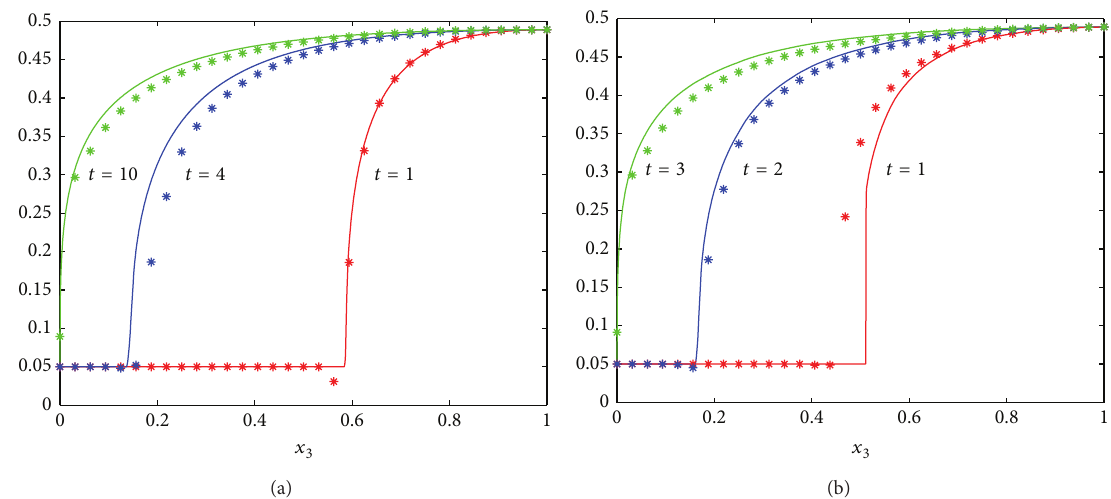
Figure 2: The HMM-FEM solution (star) compared with fine-scale solution (solid line) along the cross-section 𝑥 1 = 0.5 for periodic case (a) and random case (isotropic) (b),